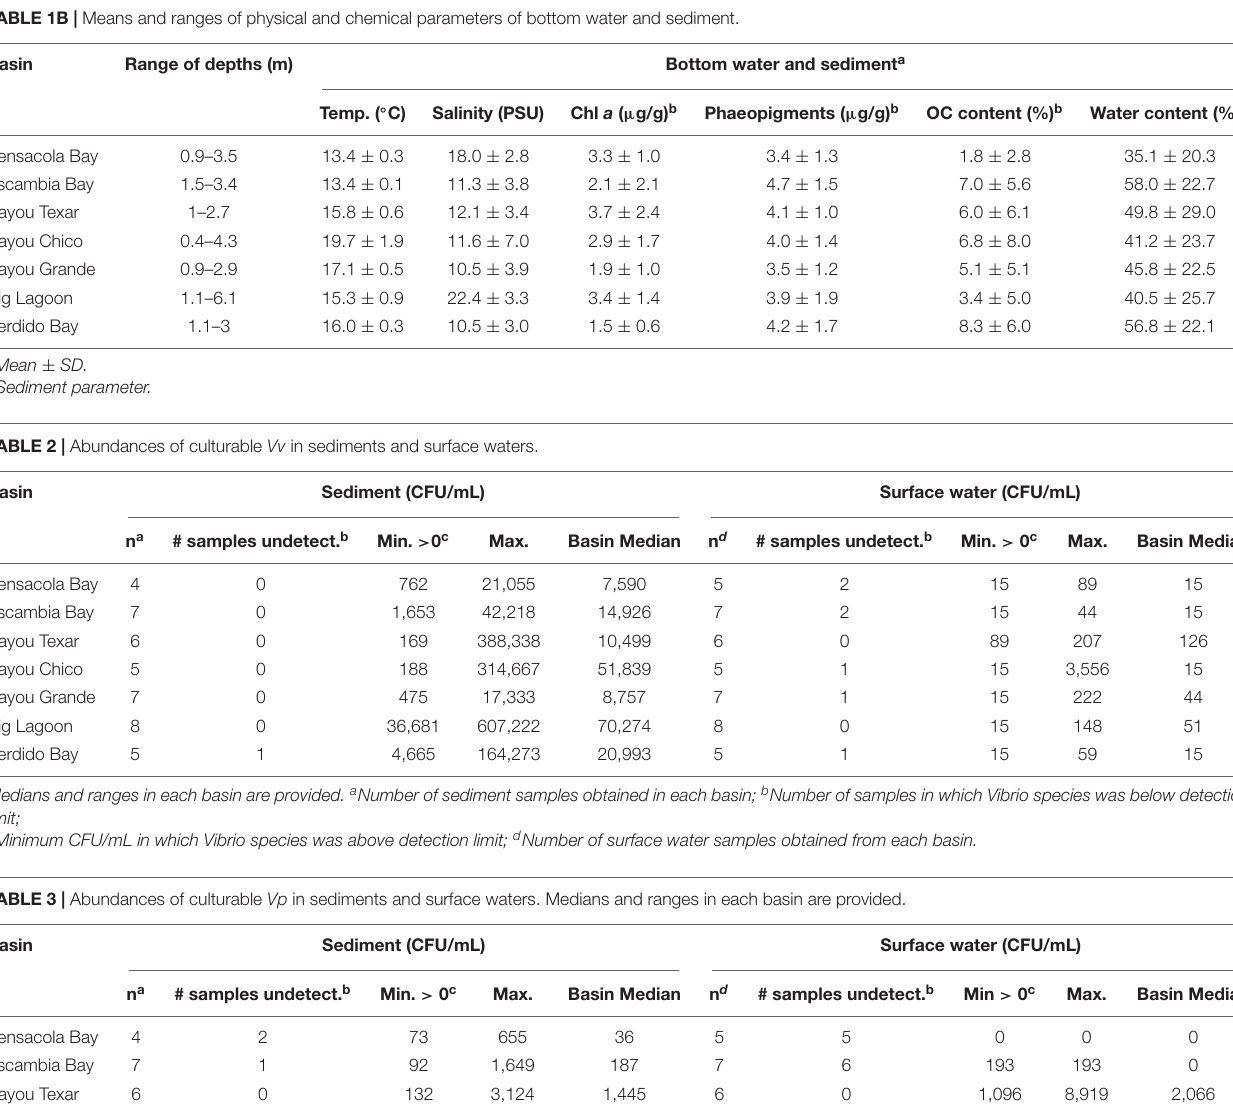
TABLE 1B | Means and ranges of physical and chemical parameters of bottom water and sediment. Basin Range of depths (m) Bottom water and sediment a